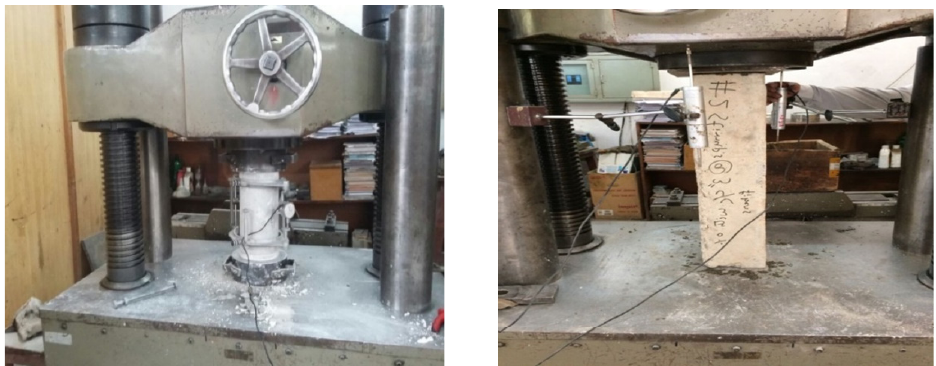
Figure 7. Cylindrical and column specimen testing in universal testing